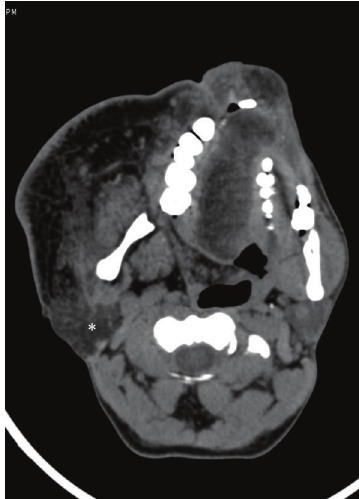
Figure 10: Axial CT scan with bone reconstructions showing widened foramen ovale (right side-arrow, left side-arrowhead).